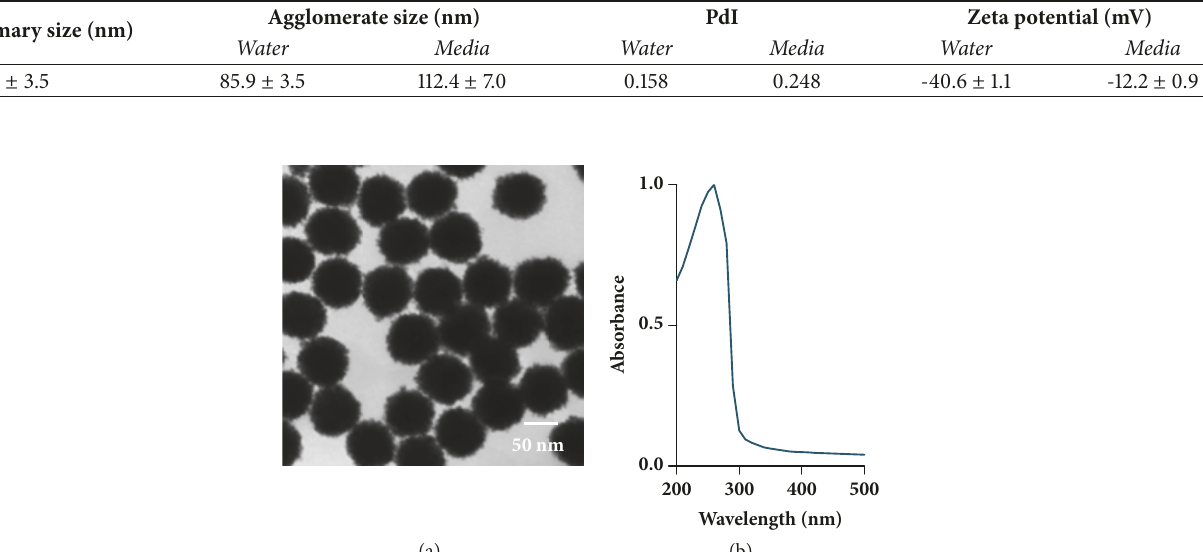
Figure 1: Characterization of the experimental PtNPs. (a) A representative TEM image of the experimental PtNPs was used to verify primary size and morphology. (b) The PtNP stock underwent UV-Vis analysis in order to obtain the unique spectral signature for these